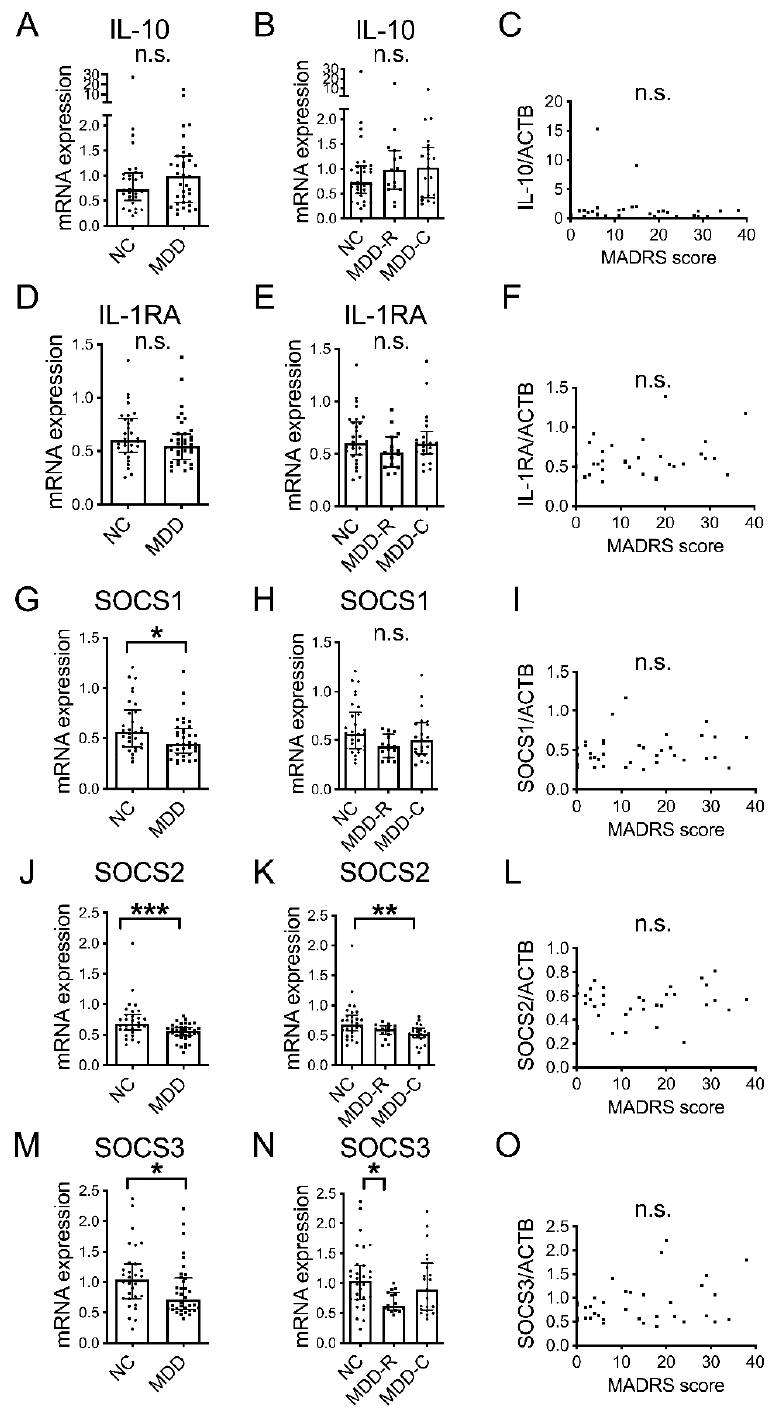
Figure 3. Blood mRNA for negative regulators of cytokine signaling in MDD and NC. Blood IL-10 mRNA ( A ), IL-1RA mRNA ( D ), SOCS1 mRNA ( G ), SOCS2 mRNA ( J ) and SOCS3 mRNA ( M ) in NC group and MDD group overall. Blood IL-10 mRNA ( B ), IL-1RA mRNA ( E ), SOCS1 mRNA ( H ), SOCS2 mRNA ( K ) and SOCS3 mRNA ( N ) in NC group and MDD-R group and MDD-C group. Horizontal lines indicate medians and error bars (IQR). * p < 0.05. ** p < 0.01. *** p < 0.001. Correlations of MADRS score with blood IL-10 mRNA ( C ), IL-1RA mRNA ( F ), SOCS1 mRNA ( I ), SOCS2 mRNA ( L ) and SOCS3 mRNA ( O ). n.s.: not significant.